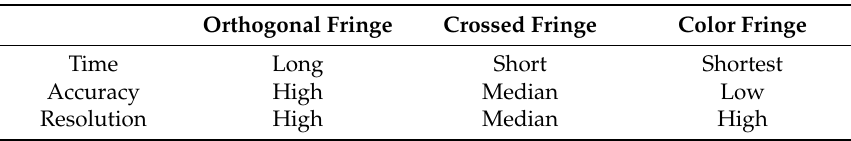
Table 1. Comparison of three fringe reflection